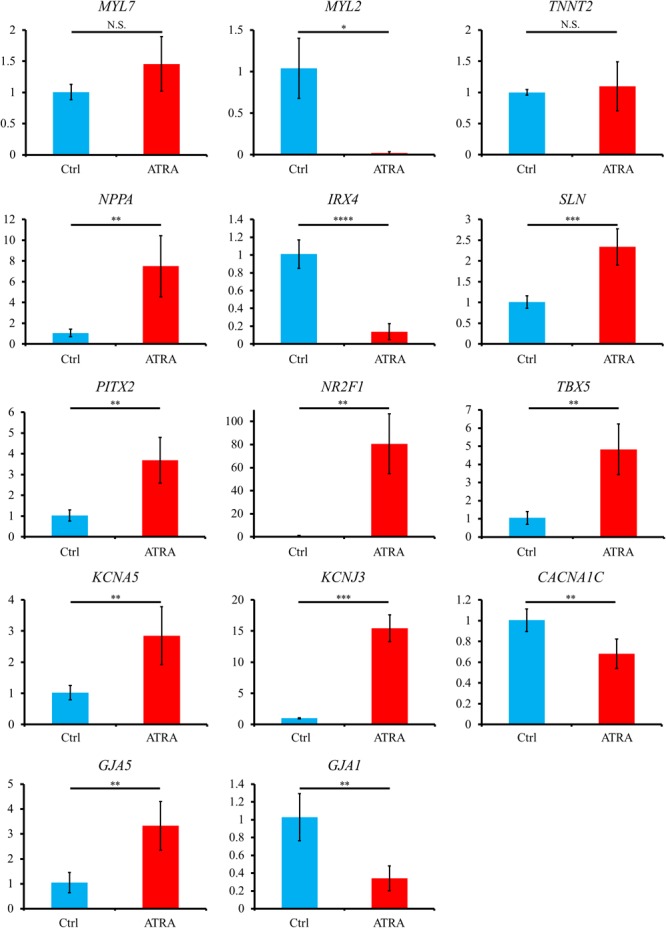
Gene expression analyses via qRT-PCR between control and ATRA-treated hiPSC-CMs. Data are presented as the means ± SD. PITX2, NR2F1, TBX5: n = 5 (ctrl) vs. 5 (ATRA); other genes: n = 4 (ctrl) vs. 5 (ATRA). N.S., not significant. ∗P < 0.05, ∗∗P < 0.01, ∗∗∗P < 0.001, ∗∗∗∗P < 0.0001 for control vs. ATRA-treated CMs. Ctrl, control hiPSC-CMs (ATRA-untreated hiPSC-CMs); ATRA, ATRA-treated hiPSC-CMs. Vertical axis denotes relative gene expression.